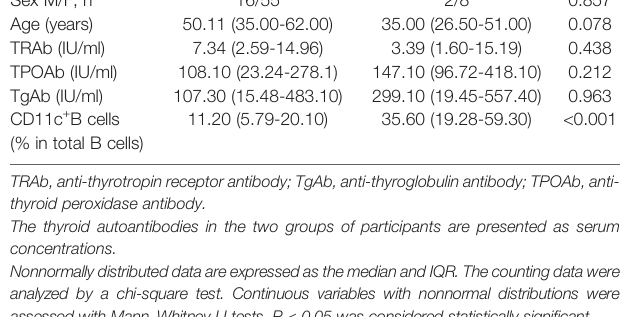
TABLE 2 | Demographic and clinical characteristics of GD patients in the peripheral blood and fi ne-needle aspiration (FNA) groups. Population Peripheral blood group FNA group